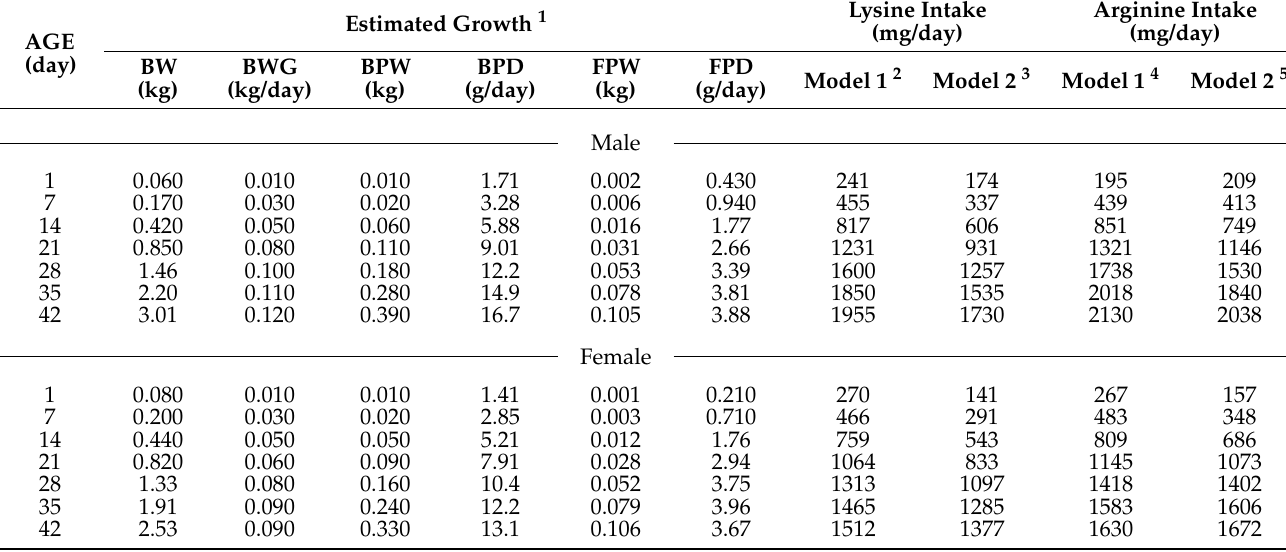
Table 8. Digestible lysine and arginine requirements for Cobb 500 ® broilers estimated by factorial models.